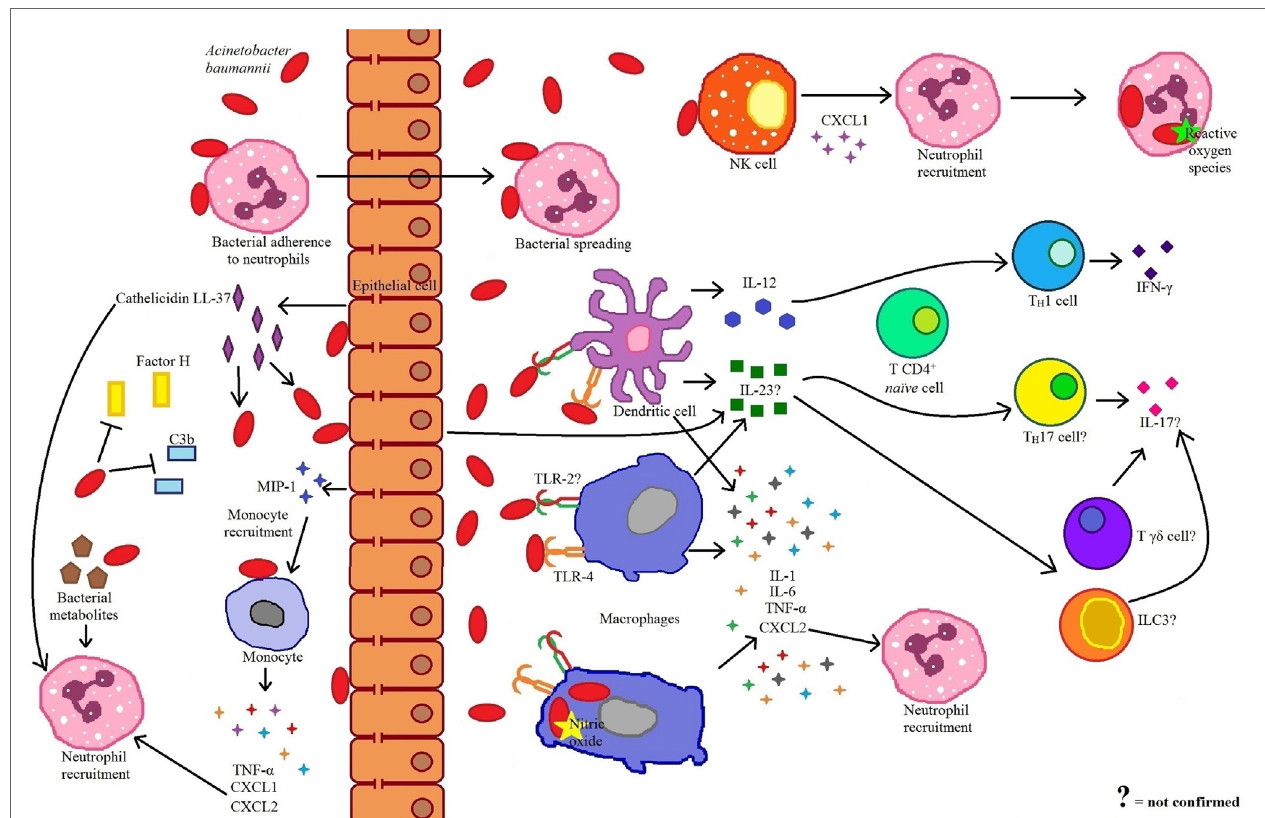
FiGURe 1 | immune response to Acinetobacter baumannii infection . Antimicrobial peptides, produced by epithelial cells are one of the first bactericidal mechanisms against A. baumannii . At the same time, these antimicrobial peptides act as chemoattractants for neutrophils. A. baumannii possesses evasion mechanisms to avoid deposition of complement system components such as factor H and C3b. Epithelial cells recognize bacteria and secrete macrophage inflammatory protein 1 (MIP-1) to recruit monocytes. In turn, these monocytes, respond to A. baumannii secreting tumor necrosis factor (TNF- α ), CXCL1, and CXCL2 to recruit neutrophils. A small percentage of bacteria evade neutrophil phagocytosis by adhering to the neutrophil surface and exploiting the migratory ability of these cells to disperse through the host. The chemokines CXCL1 and CXCL2, secreted in response to bacteria, as well as bacterial metabolites, serve